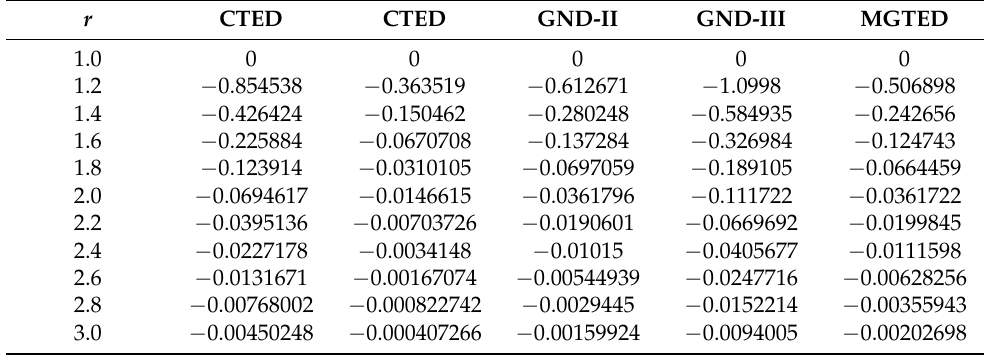
Table 3. The radial stress σ rr for different thermo-diffusion models.